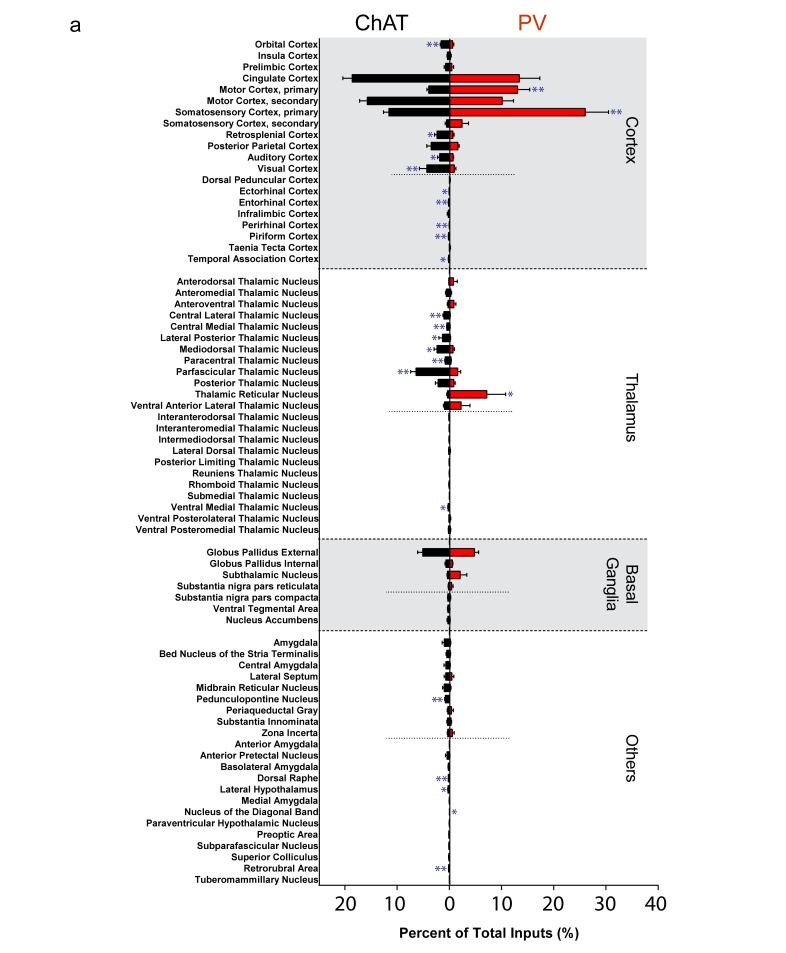
Complete list of all inputs to ChAT and PV interneurons.(a) All major (>0.4%) and minor (<0.4%) inputs to striatal ChAT (black) and PV (red) interneurons. Short dashed line represents division between major and minor inputs. Mean ± SEM. In blue, *p≤0.05; **p≤0.01.